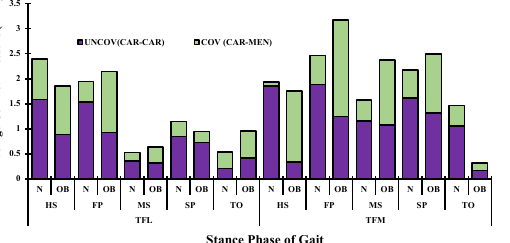
Figure 7. Predicted tibiofemoral (TF) average contact pressure at different periods of stance phase time for normal (N) and obese subjects (OB) (UNCOV: via cartilage, COV: via menisci, L: lateral, M: medial plateau).